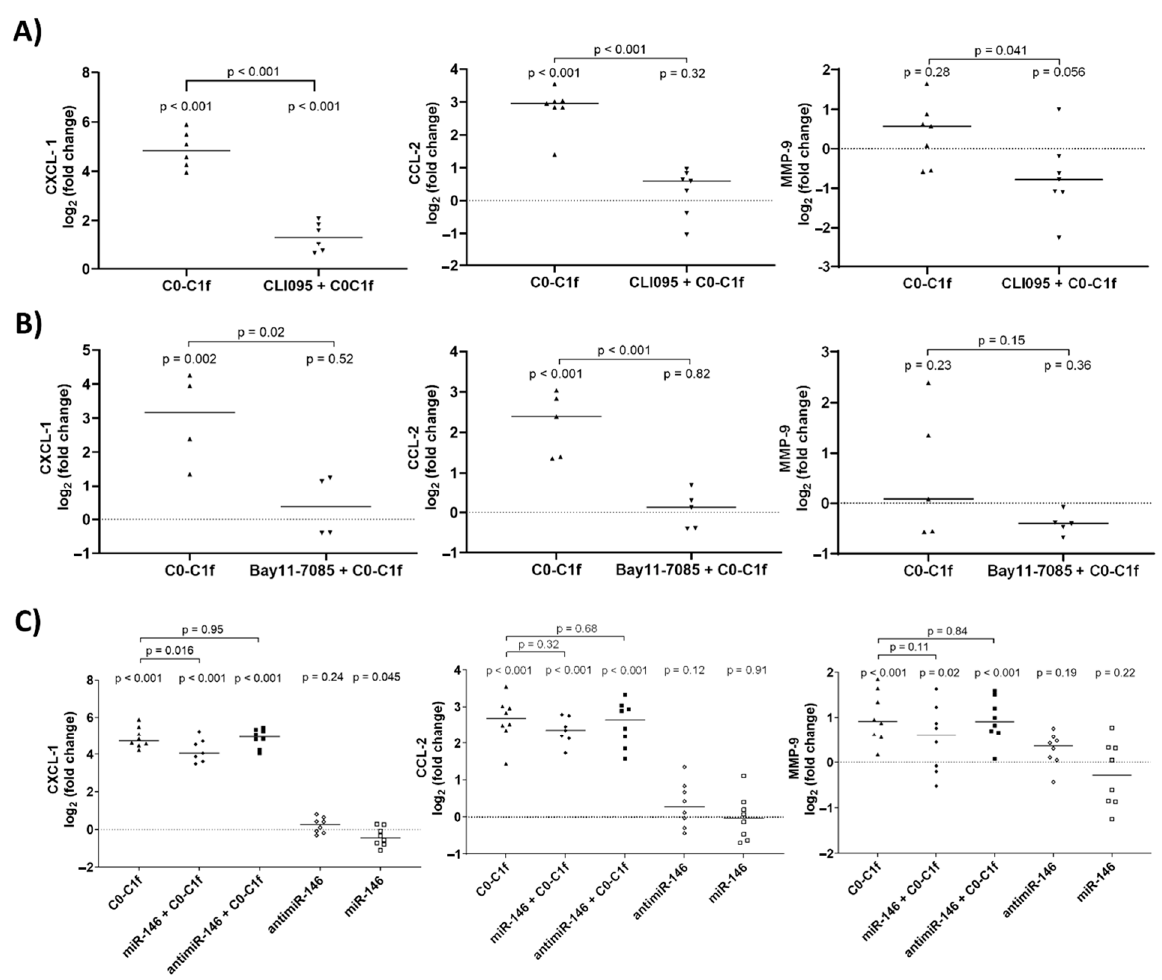
Figure 5. Effects of TLR4 and NF κ B inhibition on C0C1f signaling . ( A ) huFib cells were pretreated for 18 h with CLI-095 (TLR4 inhibitor) and then stimulated with 500 ng/mL C0-C1f for 6 h. mRNA levels of CXCL-1, CCL-2, and MMP-9 were determined by qPCR and compared using an unpaired t-test. ( B ) huFib cells were pretreated for 18 h with Bay11-7085 (NF κ B inhibitor) and stimulated with C0-C1f for 6 h. mRNA levels of CXCL-1, CCL-2, and MMP-9 were determined by qPCR. ( C ) huFib cells were transiently transfected with 25 pmol miR-146 or antimiR-146 oligos for 24 h prior to C0-C1f treatment for 6 h. CXCL-1, CCL-2, and MMP-9 mRNA were detected by qPCR. In all panels p -values above each condition refer to differences between means (horizontal lines) and 0 fold change (unstimulated controls) unless otherwise indicated. ( A ) CXCL1 n = 6; CCL2 and MMP9 n = 7; ( B ) CXCL-1 n = 4, CCL2 and MMP9 n = 5; ( C ) n = 8; n represents biological replicates.